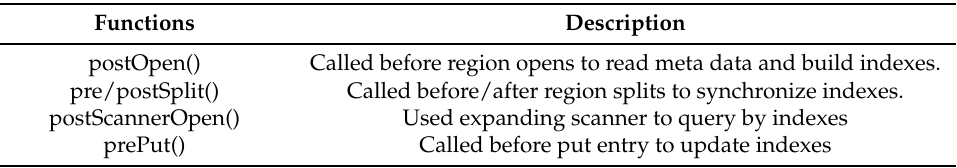
Table 1. The main functions in IndexRegionObserver.